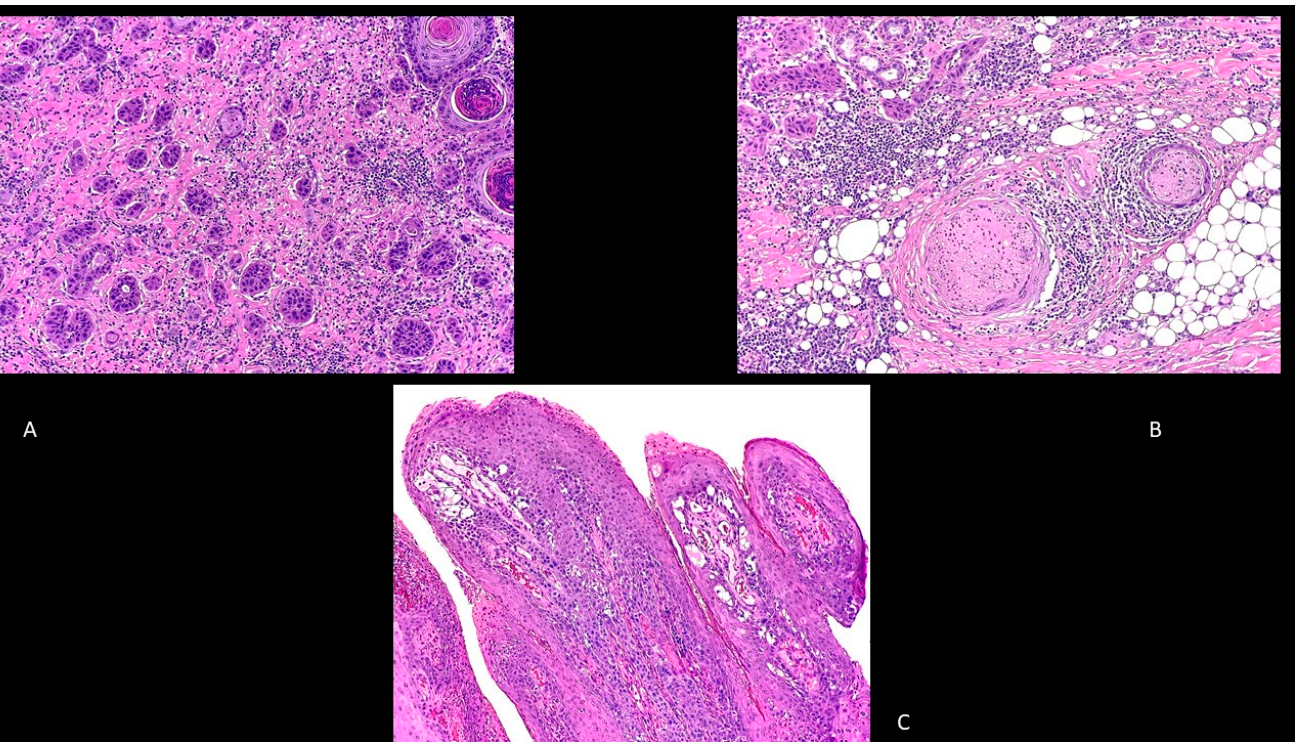
Figure 3. ( A ): Adenosquamous squamous cell carcinoma. Hematoxylin and eosin, 200×. ( B ): Perineural squamous cell carcinoma. Hematoxylin and eosin, 100×. ( C ): Papillary squamous cell carcinoma. Hematoxylin and eosin, 40×.